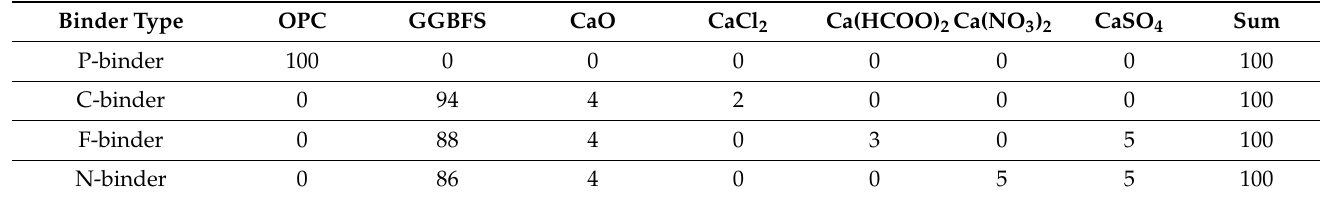
Table 2. Material proportions of binders used in concrete mixture samples